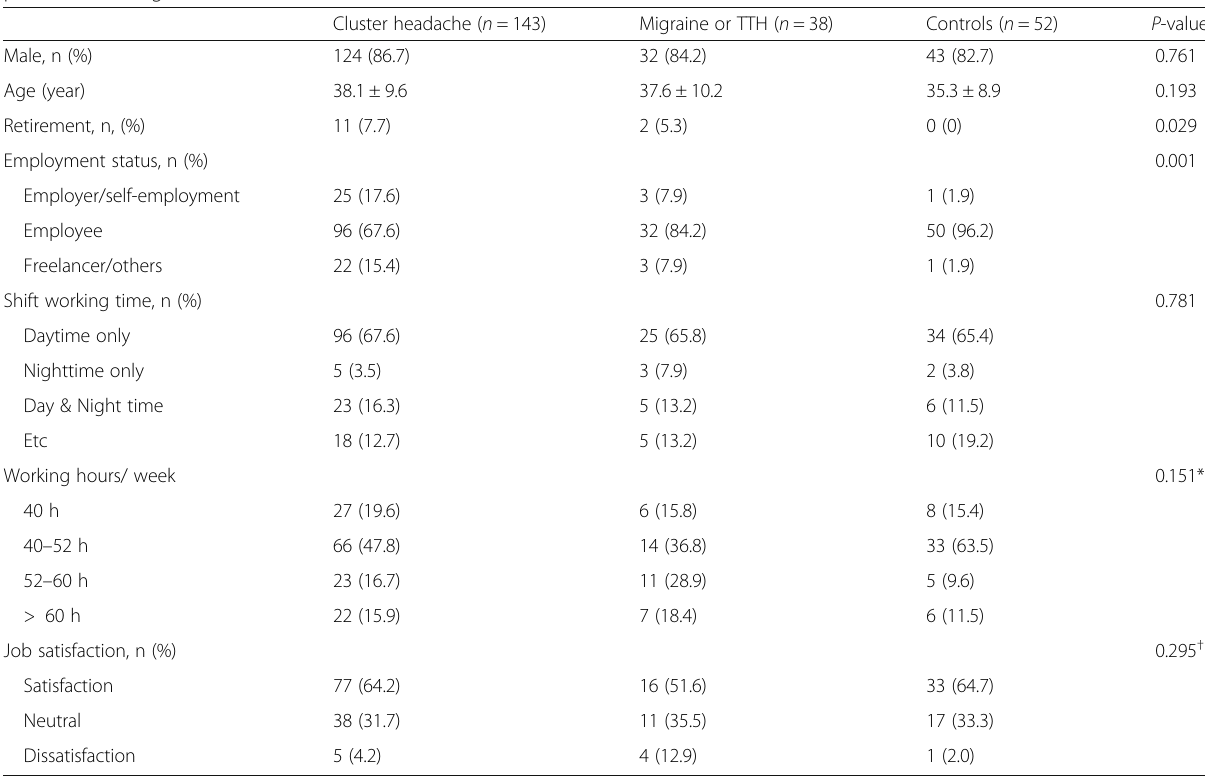
Table 1 Demographic characteristics, employment patterns, and satisfaction with occupation in patients with cluster headache, patients with migraine or TTH, and controls Cluster headache ( n = 143) Migraine or TTH ( n = 38)